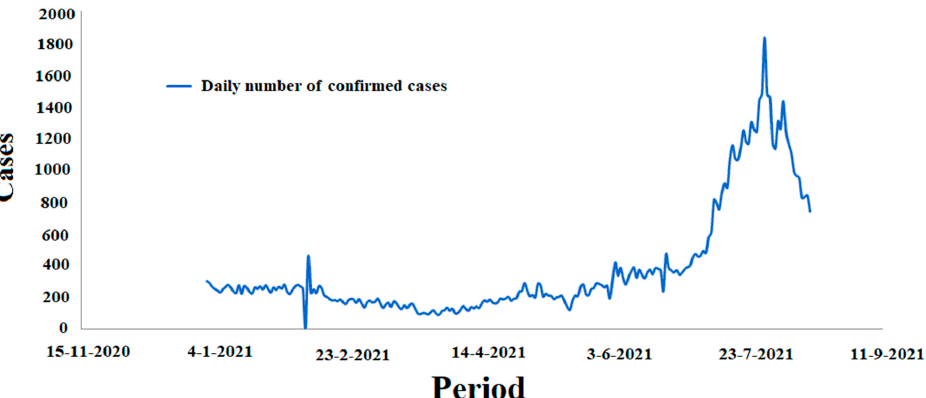
Figure 1. The number of COVD-19 cases in Algeria in the period between 1 January 2021 and 15 August 2021.